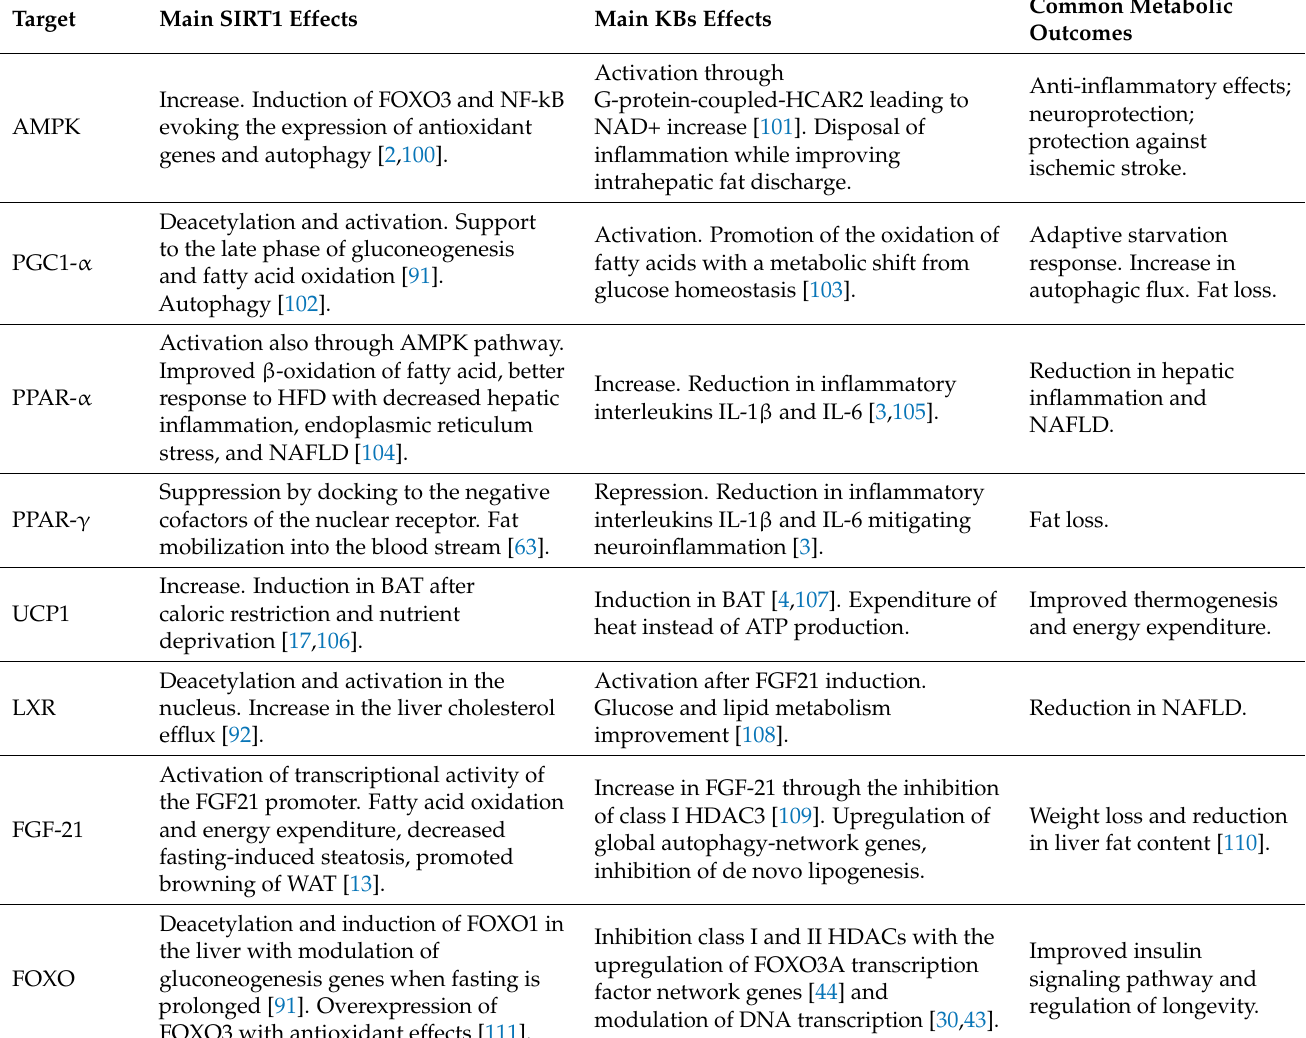
Table 1. Principal epigenetic effects mediated by KBs and SIRT1 through their targets on